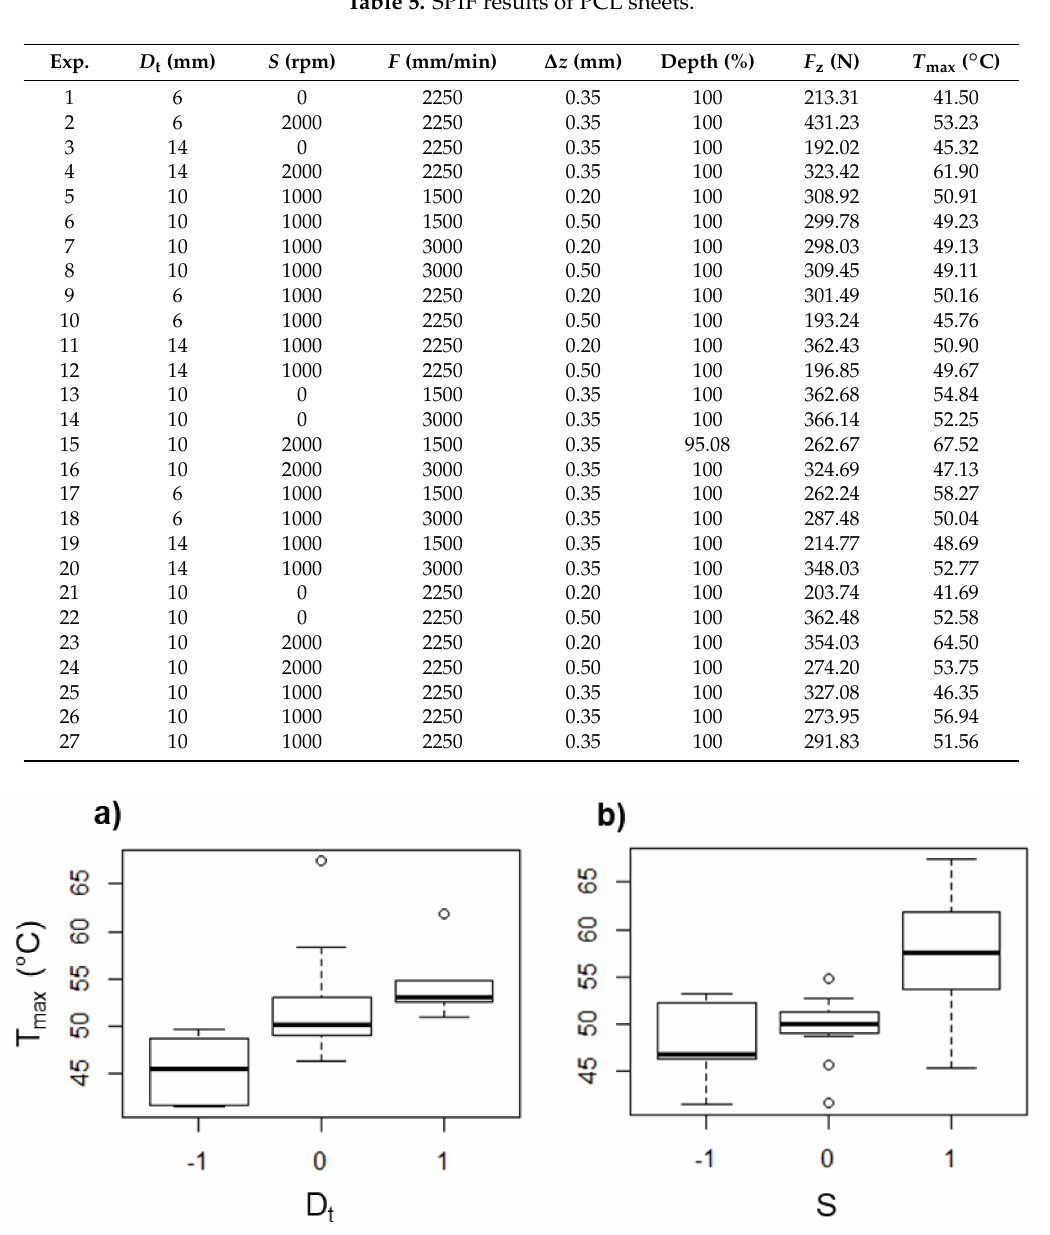
Figure 10. Box diagrams of T max (in ◦ C) for PCL as a function of ( a ) D t and ( b ) S